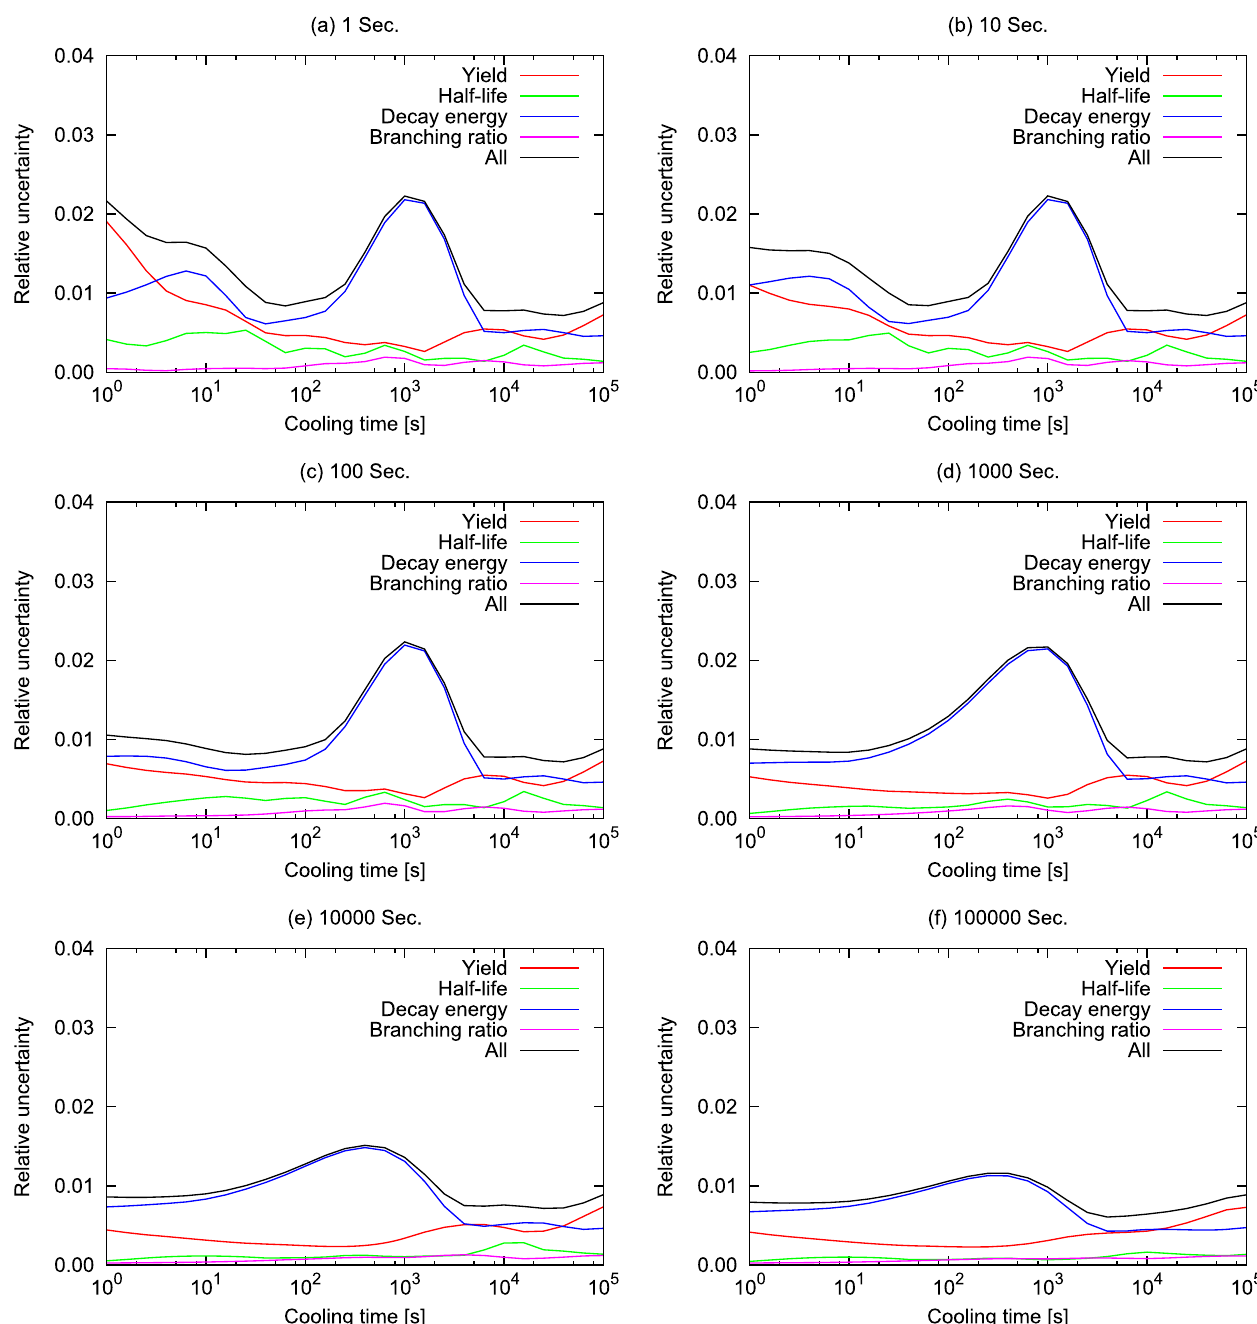
Fig. 7. Nuclear data-induced uncertainty of decay heat after uranium-235 fi ssion with thermal neutrons with different irradiation periods. Default uncertainty is assumed